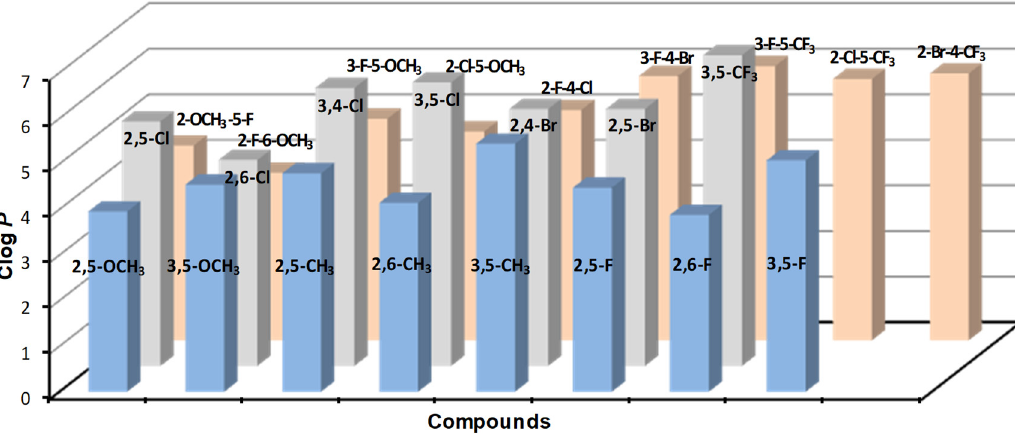
Figure 1. Graphical comparison of lipophilicity of investigated compounds expressed as Clog P, predicted by ChemBioDraw Ultra 13.0.